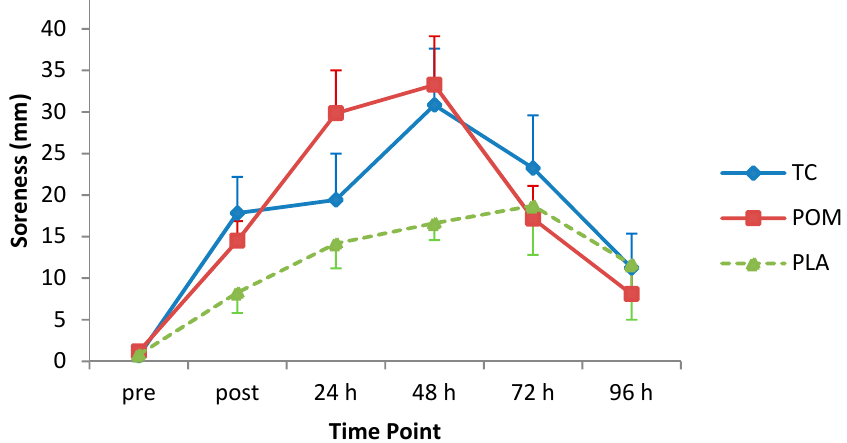
Figure 3. Change in soreness following eccentric exercise (reported on a scale of 0–100 mm). Values are displayed as mean (± SEM). Time by treatment, p = 0.10. TC = tart cherry; POM = pomegranate; PLA = placebo, n = 12 for TC, and POM and n = 11 for PLA.